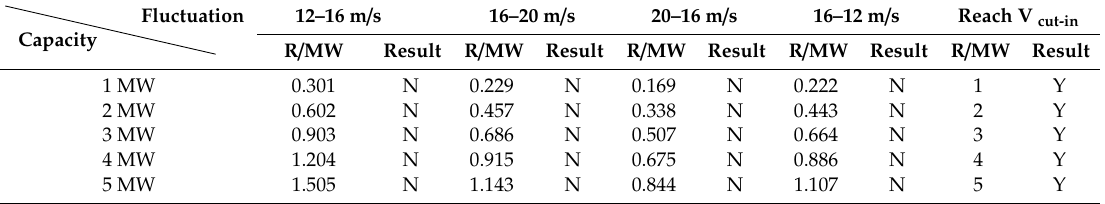
Table 2. Analysis of the complementary feasibility of the WT-HT (wind turbine-hydro turbine) hybrid system with WT capacity of 1 MW–5 MW under the influence of wind fluctuations (N-without complementary adjustment by HT; Y-with complementary adjustment by HT; O-needs further study).